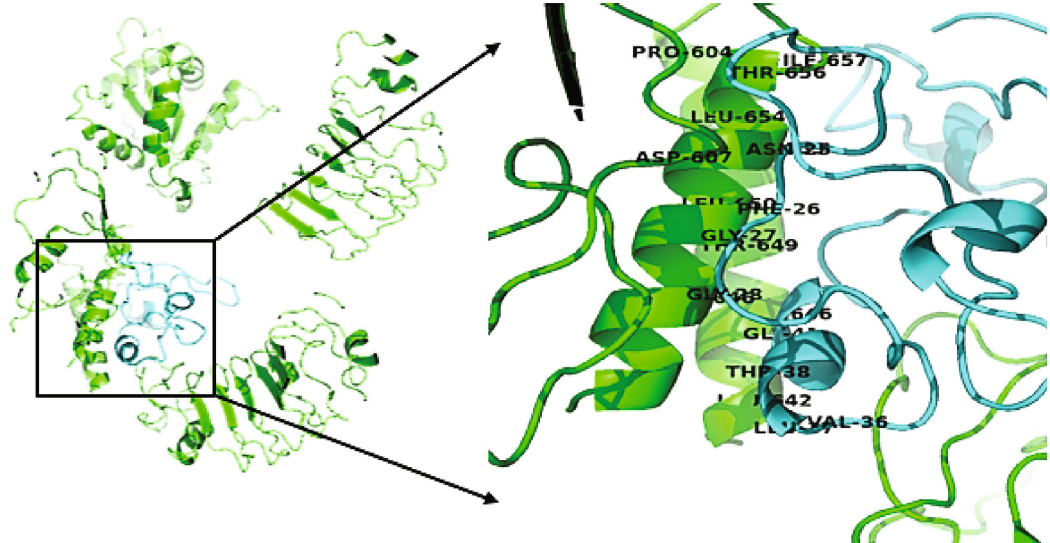
Figure 8: The interaction of the proposed vaccine construct with TLR5. The vaccine and TLR5 are shown in red and blue color, respectively. The blue color signi fi es the vaccine, while the green color also signi fi es the chain of the